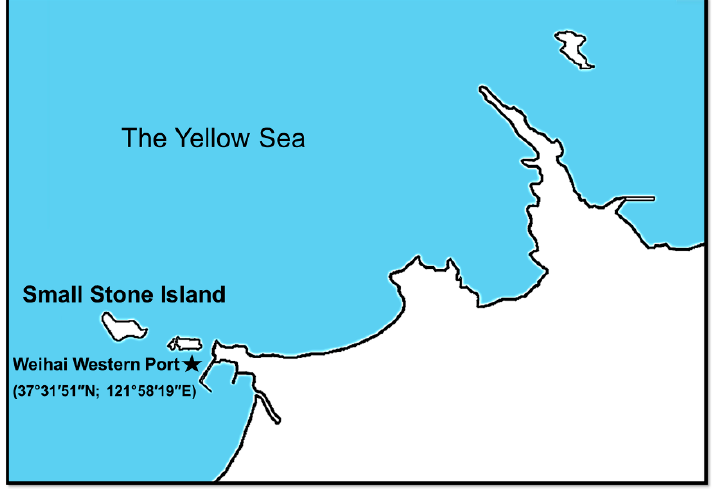
Figure 1. Location of the immersion sites for the field studies: Small Stone Island in the Western Port, Weihai, China.